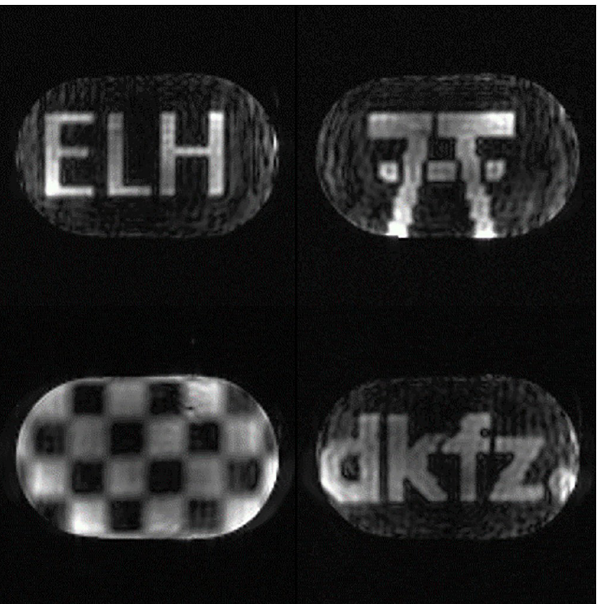
Fig 10. Selective excitation. 2D spatially selective excitation in a body-sized phantom using the 32-channel Tx/Rx body coil. The transmit sampling rate was 100 kHz.